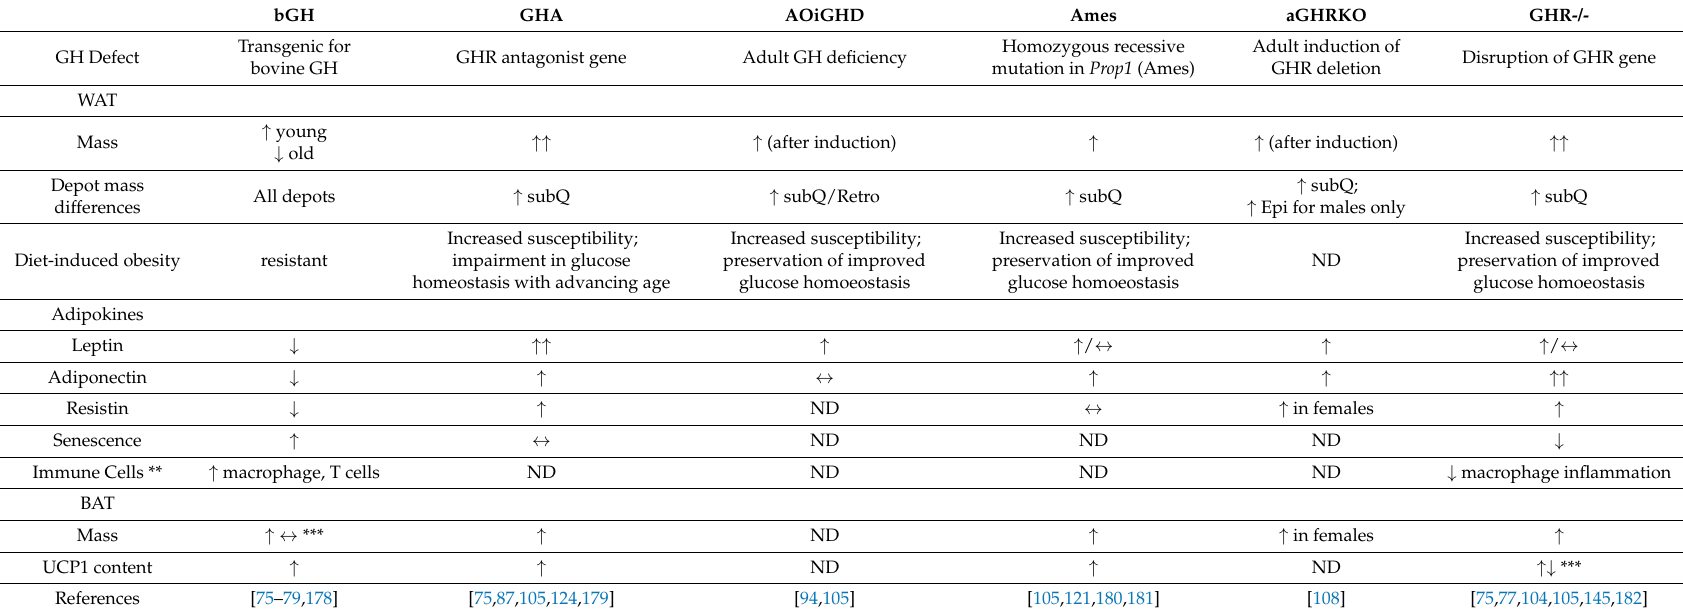
Table 3. Effects of GH on AT in various mouse lines with altered GH